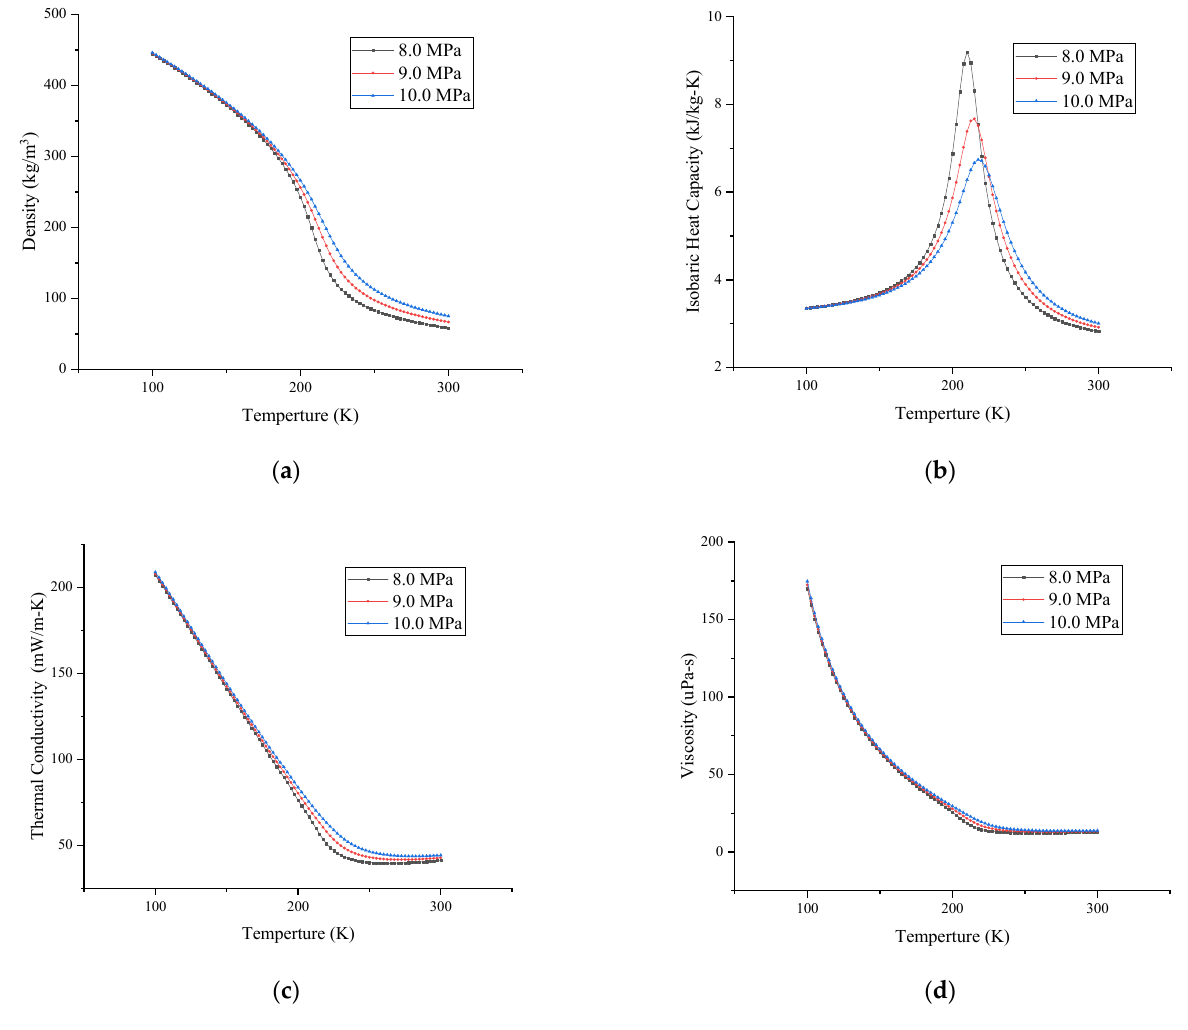
Figure 3. Properties of methane with respect to temperature at three different pressures: ( a ) density; ( b ) isobaric heat capacity; ( c ) thermal conductivity; ( d ) viscosity. ( b ) isobaric heat capacity; ( c ) thermal conductivity; ( d )